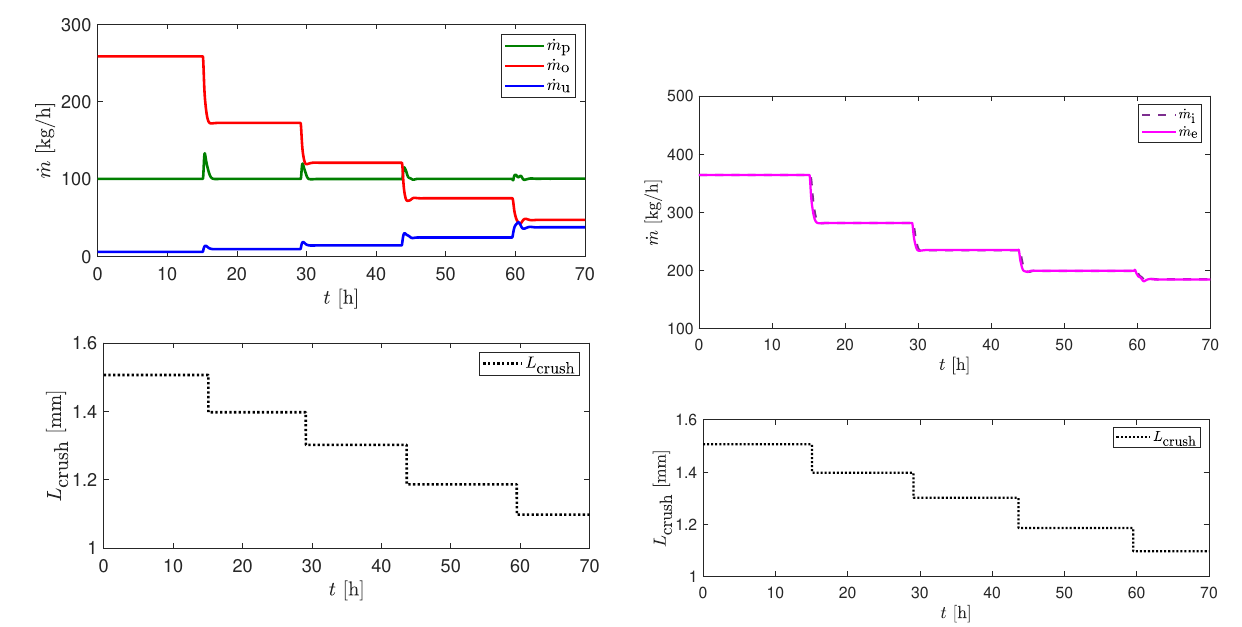
Figure 6: Mass flow rates of over-sized, product-sized and under-sized particles as a response to the step-by-step change of the crusher gap ( L crush = 1 . 5 → 1 . 4 → 1 . 3 → 1 . 2 → 1 . 1 mm).